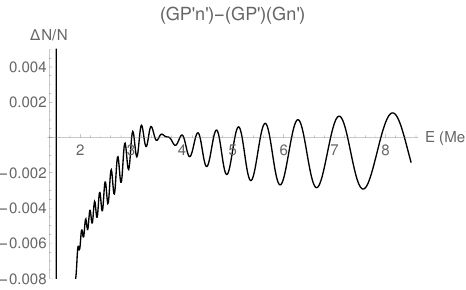
Figure 4 . Fractional di(cid:11)erence between the spectra obtained with the approximation ( GP 0 )( Gn 0 ) and with ( GP 0 n 0